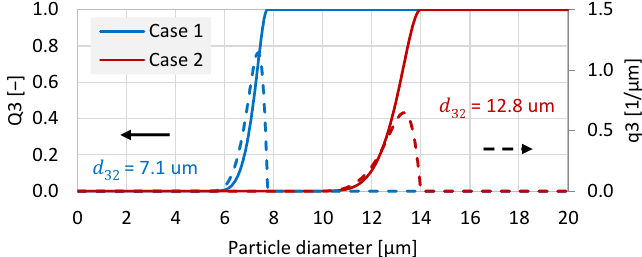
Figure 14. Cumulative and density particle size distribution and Sauter mean diameter of particles at the end of a batch process of synthesis in the reactor unit for two case studies (Suspension stream in